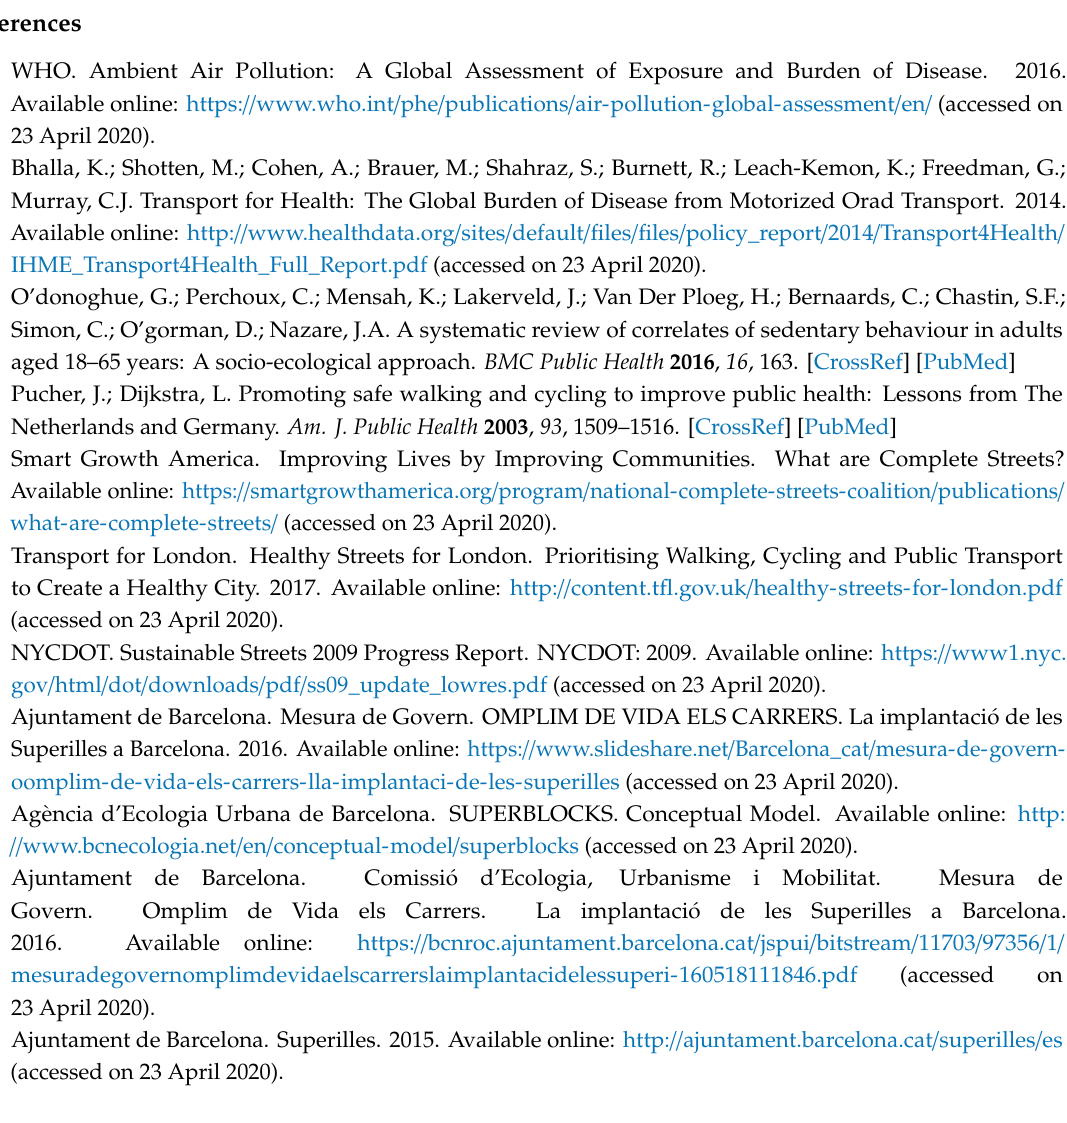
s1, Figure S1: Interventions performed at the superblock of Poblenou in four categories (recreational areas, play areas, sports areas, and urban renewal locations), Figure S2: Plaça del mercat (newly created plaza in Sant Antoni neighborhood, right) and crossing similar to what it was before (Manso with Viladomat streets, left), Figure S3: Black carbon measurements in the Horta superblock, Figure S4: Health impact assessment (HIA) improvements provided by a pre–post assessment and qualitative study presented in this protocol, Supplementary Material: